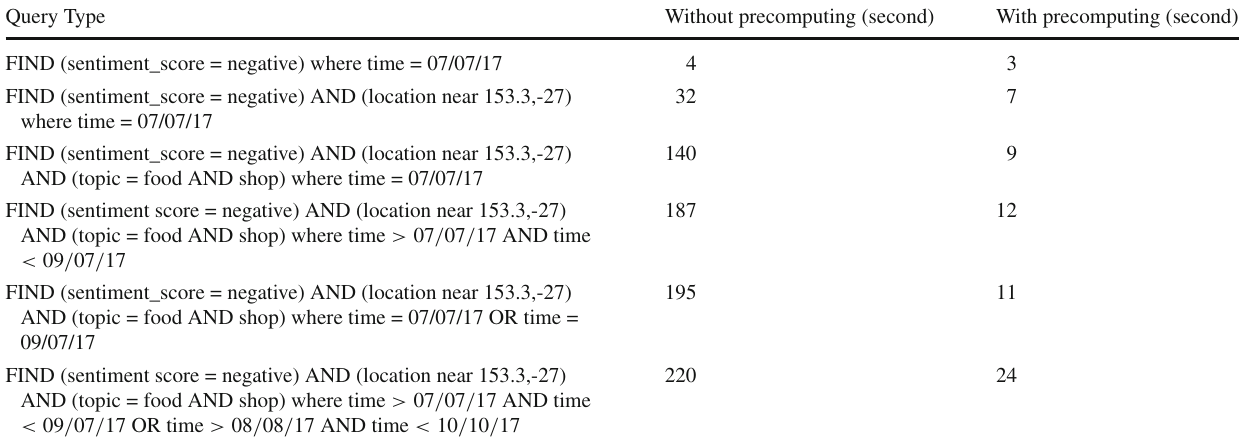
Table 1 Average end-to-end query processing time with and without precomputing Query